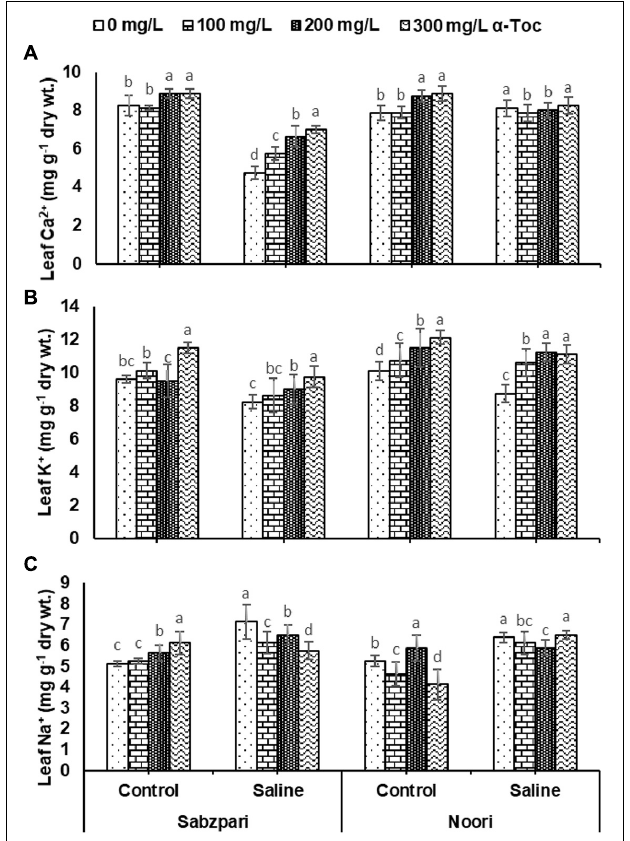
FIGURE 7 | Leaf Ca 2 + (A) , Leaf K + (B) Leaf Na + (C) of okra varieties sprayed with different levels of α -tocopherol under saline conditions Values represent means ± S.D. Significant differences among row spacing were measured by the least significant difference (LSD) at p > 0.05 and indicated by different letters.